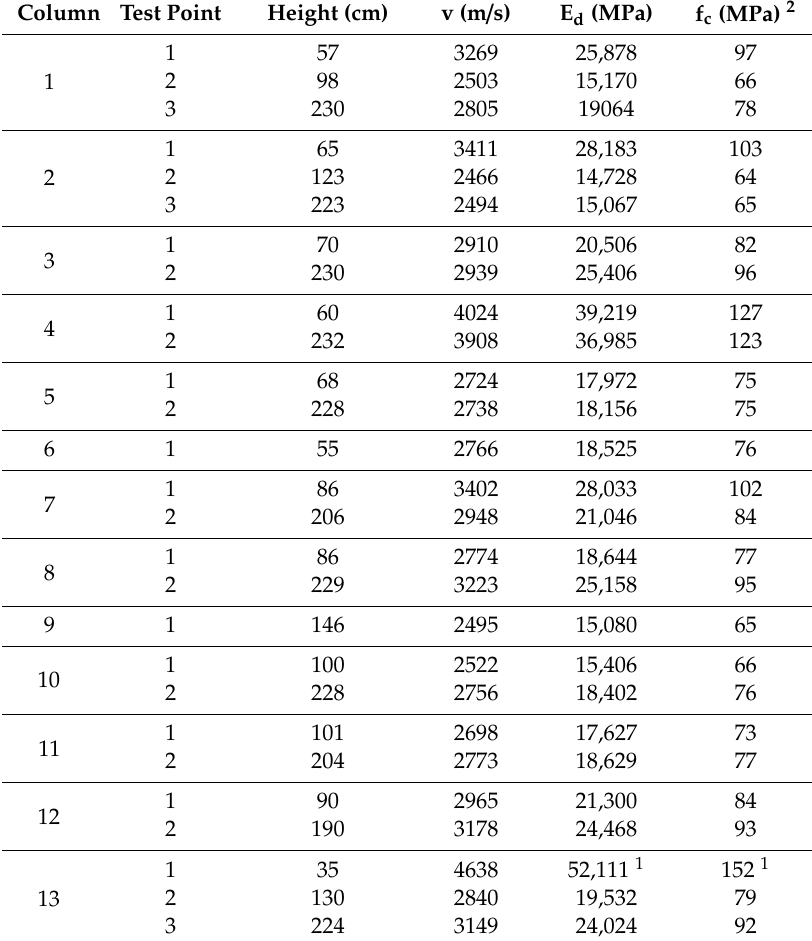
Table 1. Values of dynamic modulus by ultrasonic tests on Via Crucis portico